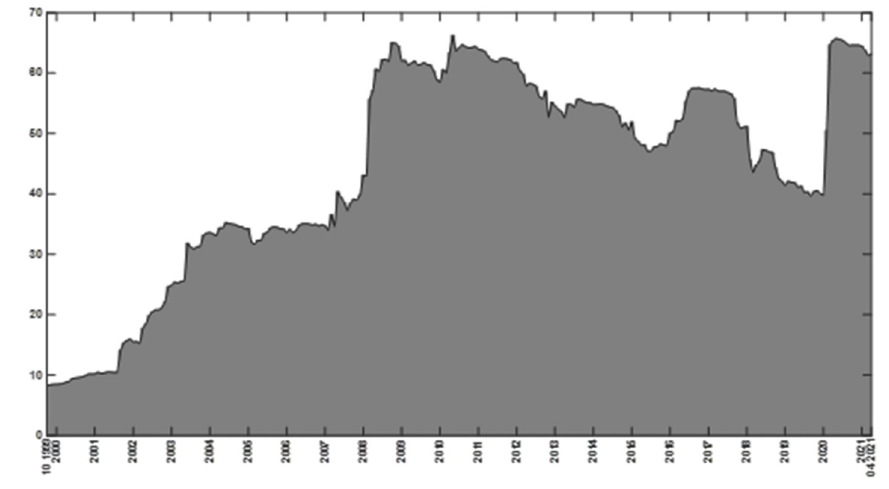
Figure 3. Dynamic total connectedness of the EA peripheral countries' CLIFS values.